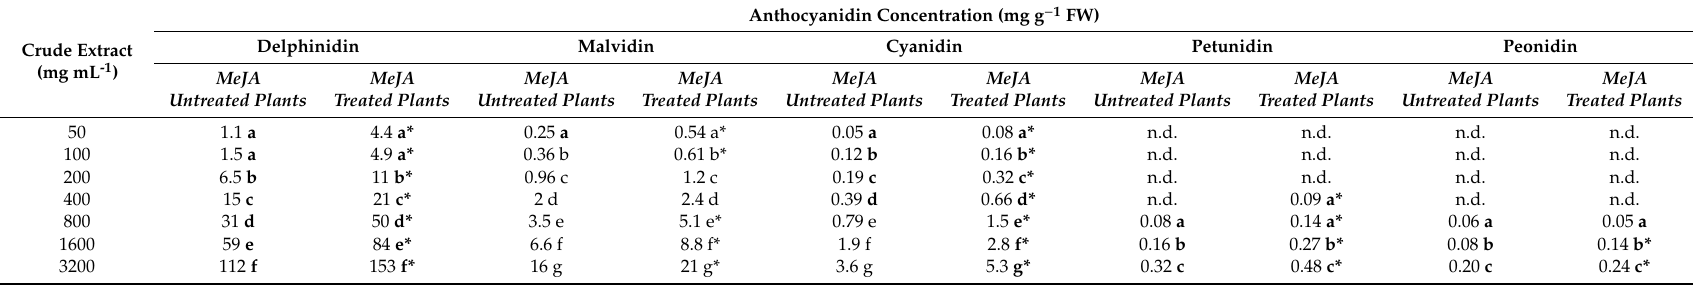
Table 4. Anthocyanidin composition (determined by HPLC-DAD) of leaf crude extracts from blueberry plants untreated and treated with MeJA.